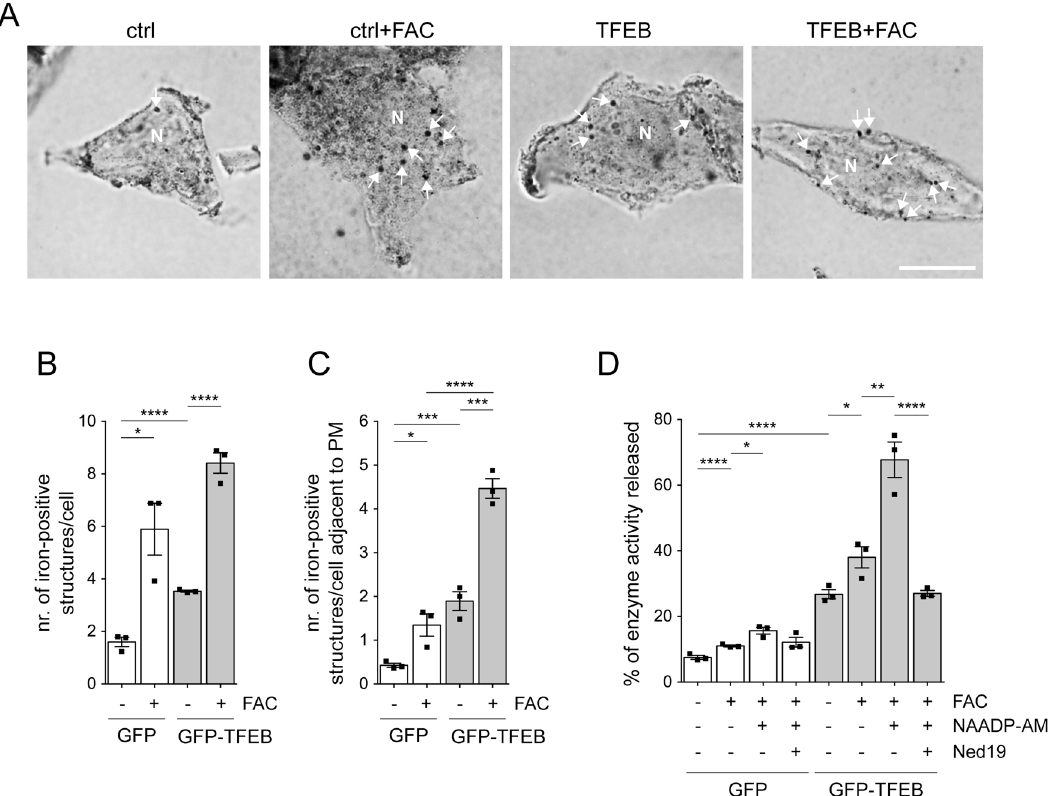
Fig. 6 TFEB expression increases peripheral iron-positive endolysosomes and triggers lysosomal exocytosis. A Example of control GFP- expressing (ctrl) or GFP-TFEB-expressing HEK293T cells either without or with FAC treatment (50 μ M, 48 h) as indicated, and stained for intracellular iron using the sul fi de-silver method. Scale bar, 10 μ m. B Quanti fi cation of the total number of iron-positive structures per cell in the absence or presence of FAC treatment as indicated. C Same as in B , but quanti fi cation of peripheral iron-positive structures per cell. D Activity of lysosomal enzyme acid phosphatase (percentage released as compared to total) was determined in culture medium from cells transfected with either GFP or GFP-TFEB, and treated with or without FAC (50 μ M, 48 h), NAADP-AM (100 nM, 12 h) or Ned19 (1 μ M, 12 h) as indicated. Bars represent mean ± s.e.m. (**** p < 0.001; *** p < 0.005; ** p < 0.01; * p <